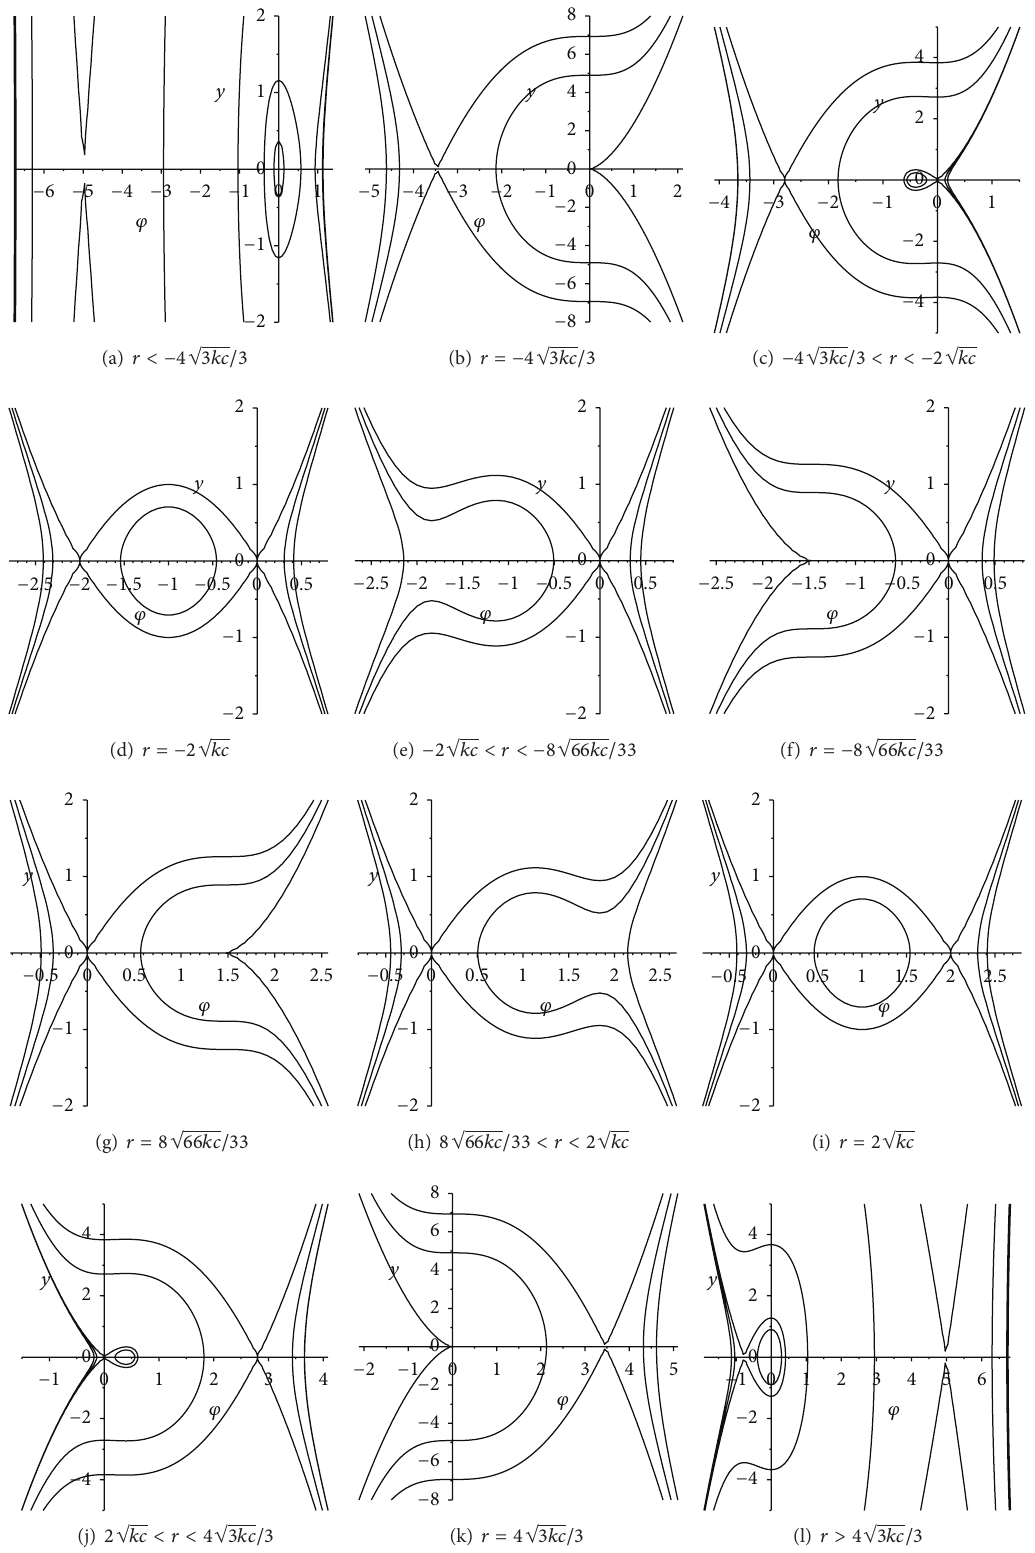
Figure 2: The bifurcation phase portraits in different regions of Figure 1(a) for the system